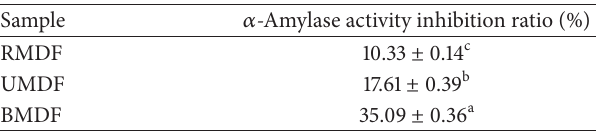
Table 4: Effect of different IDF fractions on 𝛼 -amylase activity inhibition